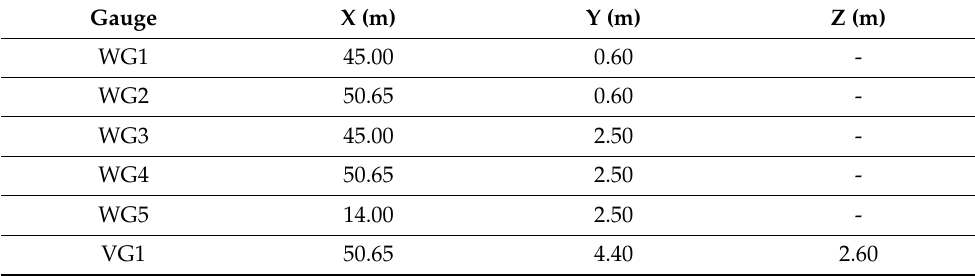
Figure 2. Schematic representation of the NWT with the conical substructure: front view. Fourteen gauges were placed near the substructures along the z direction every 30 ° . The details of the fourteen gauges are shown in Figure 3 and Table 3.